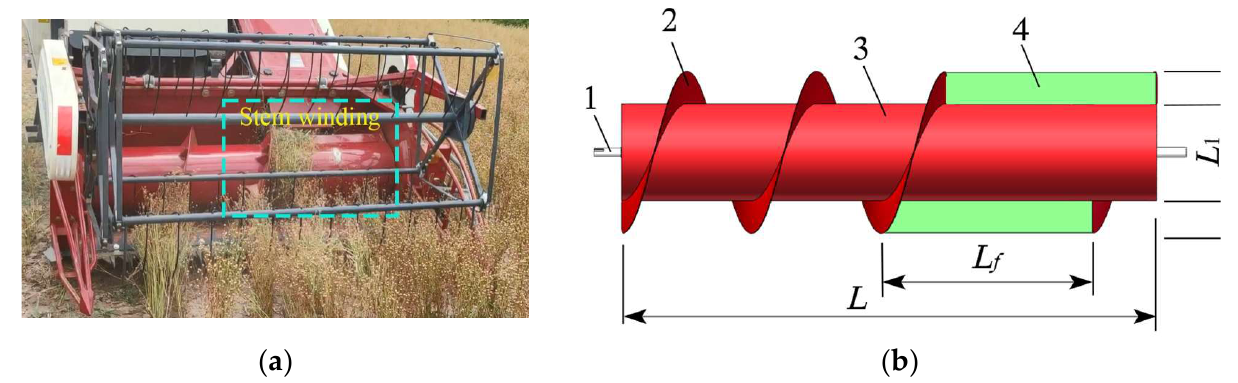
Figure 3. Diagram of the churn winding and anti-winding device: ( a ) Churning dragon wrap. ( b ) Diagram of the anti-tangle device. (1) Churning dragon wrap. (2) Diagram of the anti-tangle device. (3) Stirrer. (4) Anti-winding plate. Note: L is the length of the churn in mm. L f is the length of the anti-winding plate in mm. L 1 is the diameter of the churn in mm. L 2 is the long shaft of the anti-winding churn in mm.